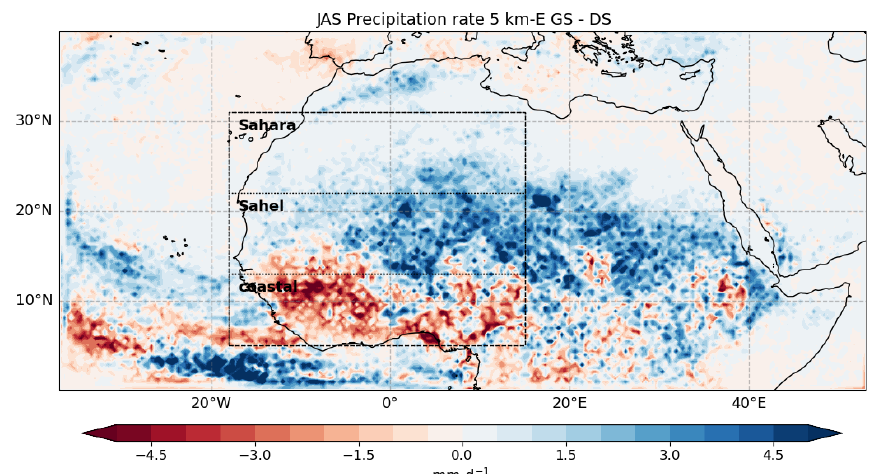
Figure 8. JAS mean difference in precipitation rate between the 5km-E GS and DS simulation. The dashed box indicates the WA analysis domain.